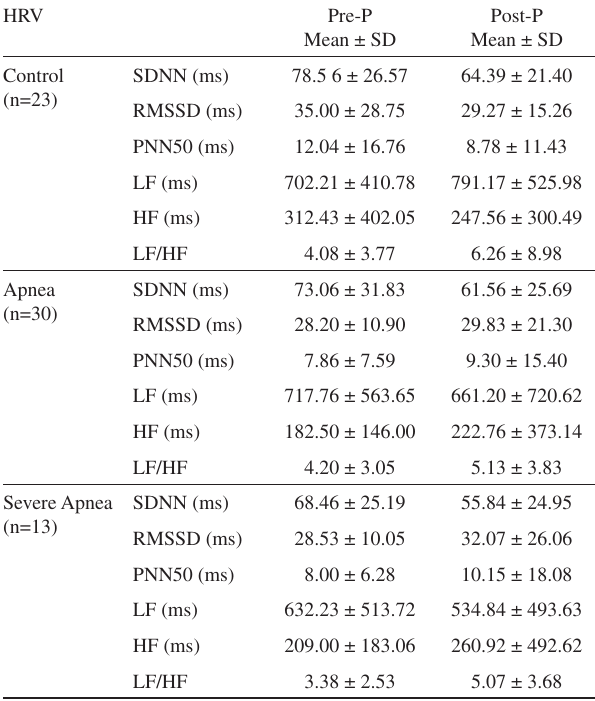
Table 2 - Heart rate variability in the three groups during pre- and post- polysomnography